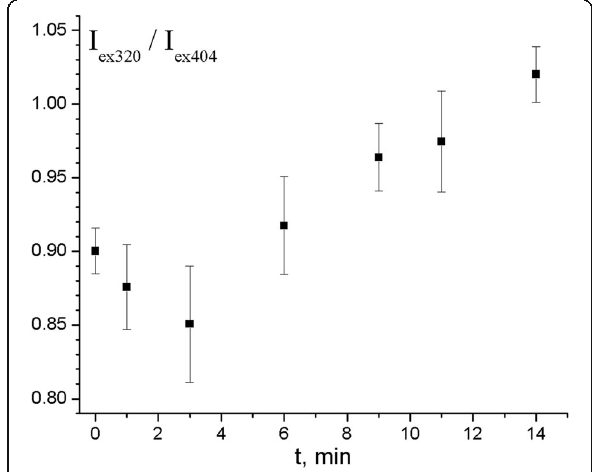
the PNIPAM-bound chlorin e to the total emission of 6 chlorin e is close to maximum). This band is weak at 6 first, but further, its intensity strongly increases with time (Fig. 7). At the same time, this PS-PPO band is very weak in the excitation spectrum of chlorin e upon 6 emission at 660 nm (i.e., at maximum of the free chlorin e spectrum) even after 100 min after the addition of 6 chlorin e . 6